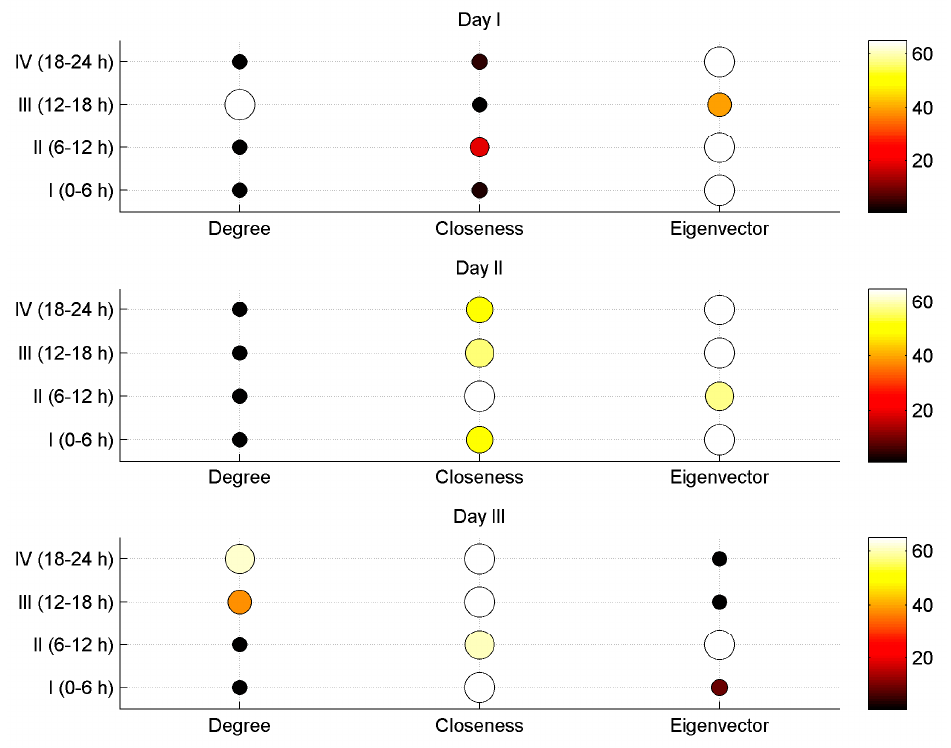
Figure6. DistributionofperformanceimprovementforcalculationofDegree, ClosenessandEigenvector centralities in Twitter Figure 6. Distribution of performance improvement for calculation of Degree, Closeness and Eigenvector centralities in Twitter dataset.